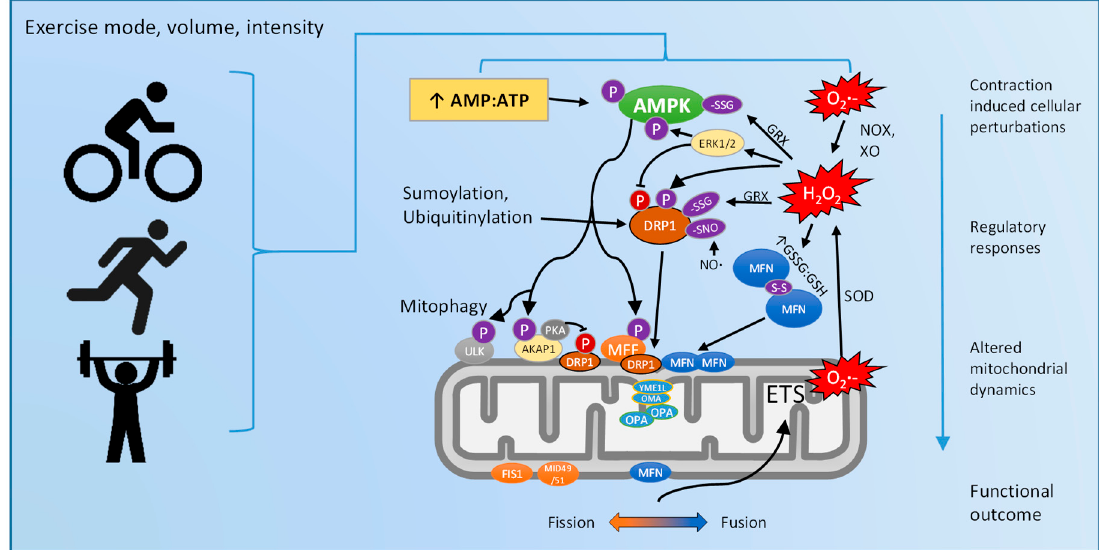
Figure 4. Proposed effects of exercise on mitochondrial dynamics via AMPK and ROS linked mechanisms. Exercise of distinct mode, volume, and intensity may have differential effects on cellular perturbations. This includes an increased bioenergetic demand resulting in an increased AMP:ATP ratio, along with increased contraction mediated and post-exercise ROS formation. These perturbations are sensed by AMPK, which initiates a cascade of phosphorylation signaling events that are interlinked with redox mediated post translational modifications. The specific activation or inhibition of each fission (depicted in orange) or fusion (depicted in blue) effector results in a net mitochondrial dynamics response which allows the myocyte to better meet the localized bioenergetic requirements of subsequent energetic stress.